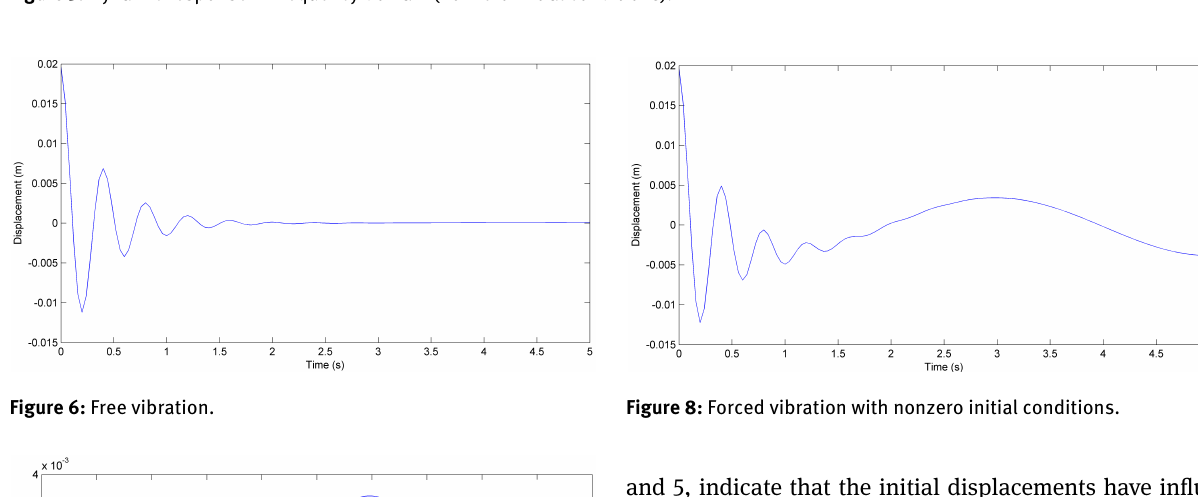
Figure 5: Dynamic response in frequency domain (nonzero initial conditions).